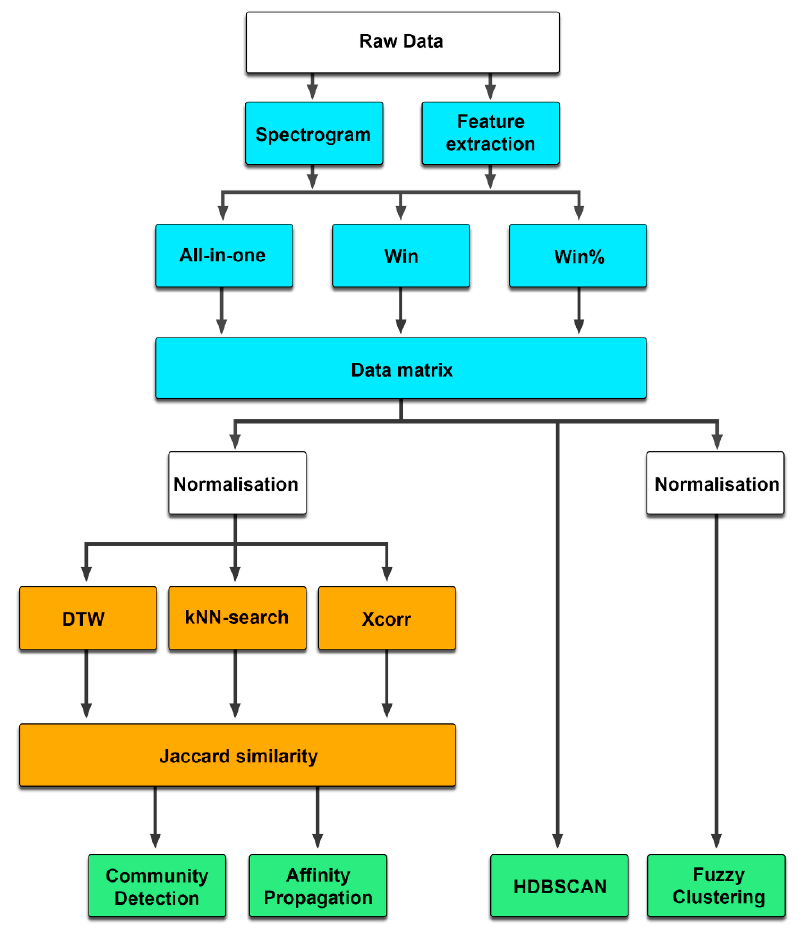
Figure 1. Sequence of clustering procedures. Possible combinations are shown, resulting in 48 different procedures.